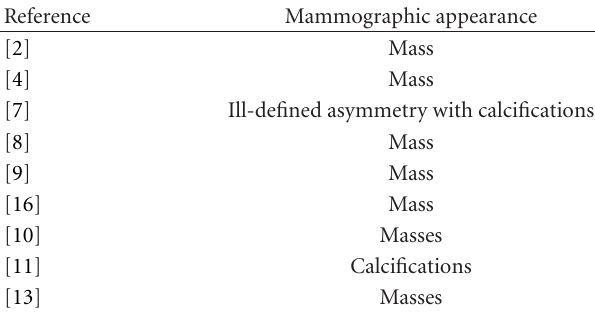
Table 2: Mammographic appearance of breast